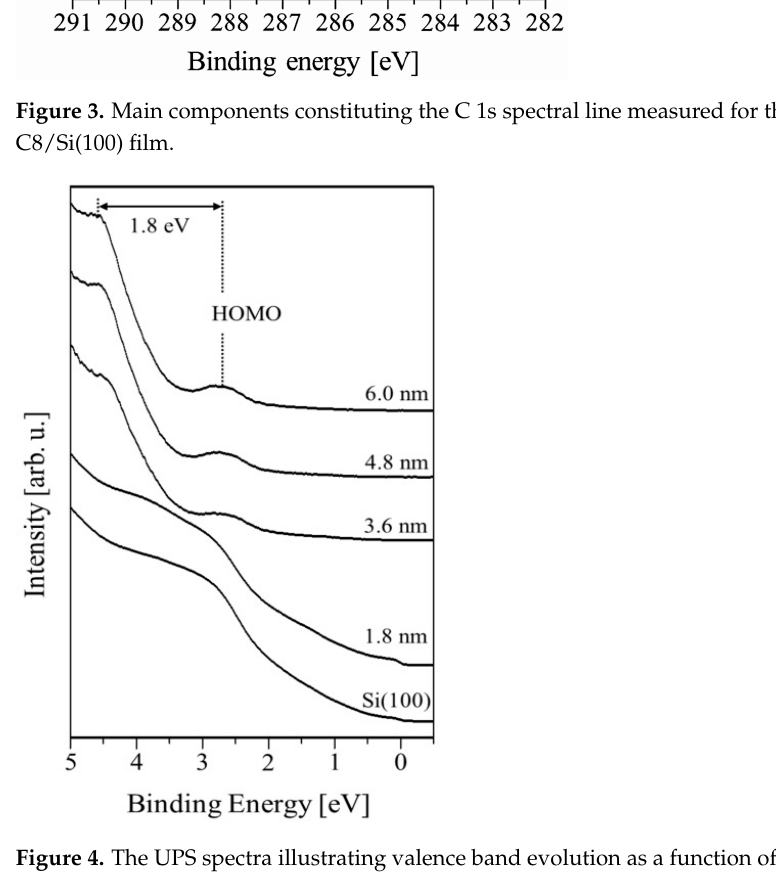
Figure 4. The UPS spectra illustrating valence band evolution as a function of the PTCDI-C8/Si(100) film thickness.